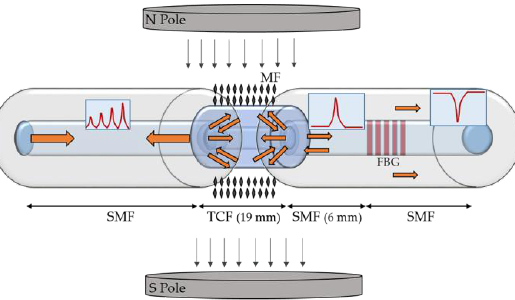
Figure 3. Schematic representation of the TCF-FBG based magnetic field sensor (adapted from [34]).